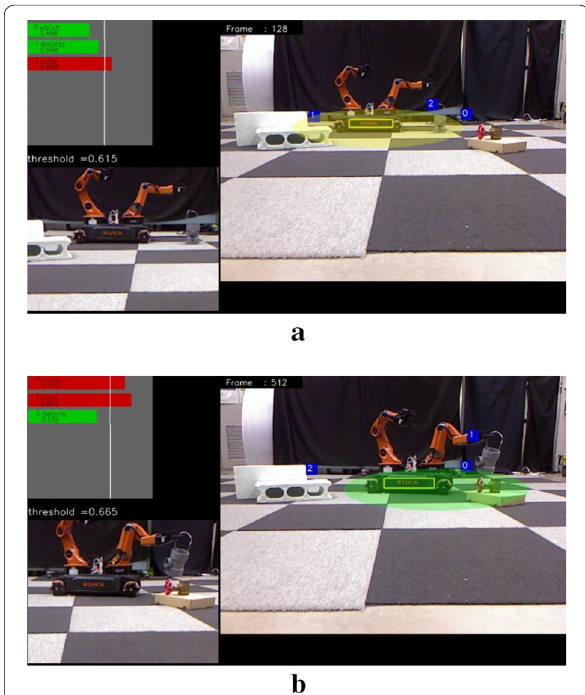
Fig. 10 ROI selected during transportation task. a Frame Frame 512 =